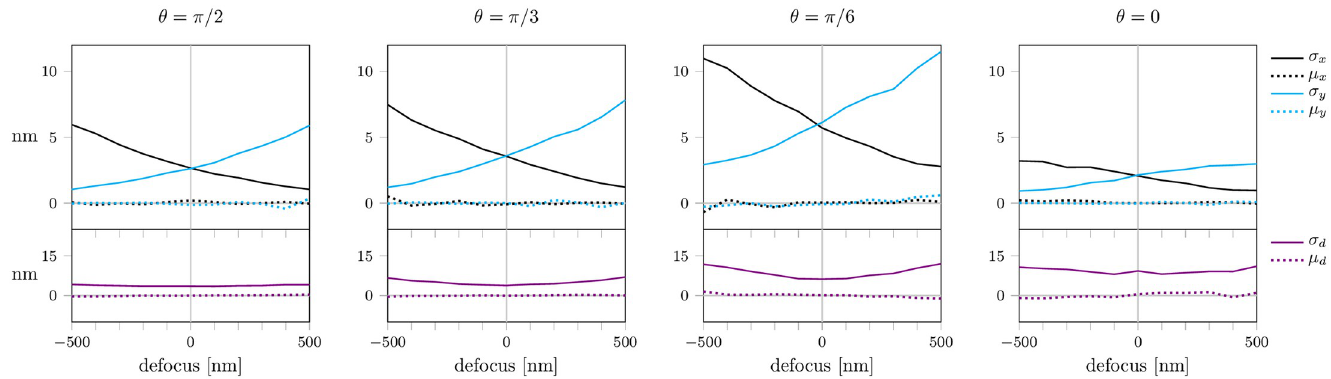
Fig 7. Influence of uncertainties in dipole orientation. Simulations and fitting procedure were analogous to Fig 4, except for adding errors in dipole orientation. Errors were distributed normally with standard deviation of 2˚. Background noise was set to b = 100. A list of all simulation parameters is given in S1 Table in S1 File.